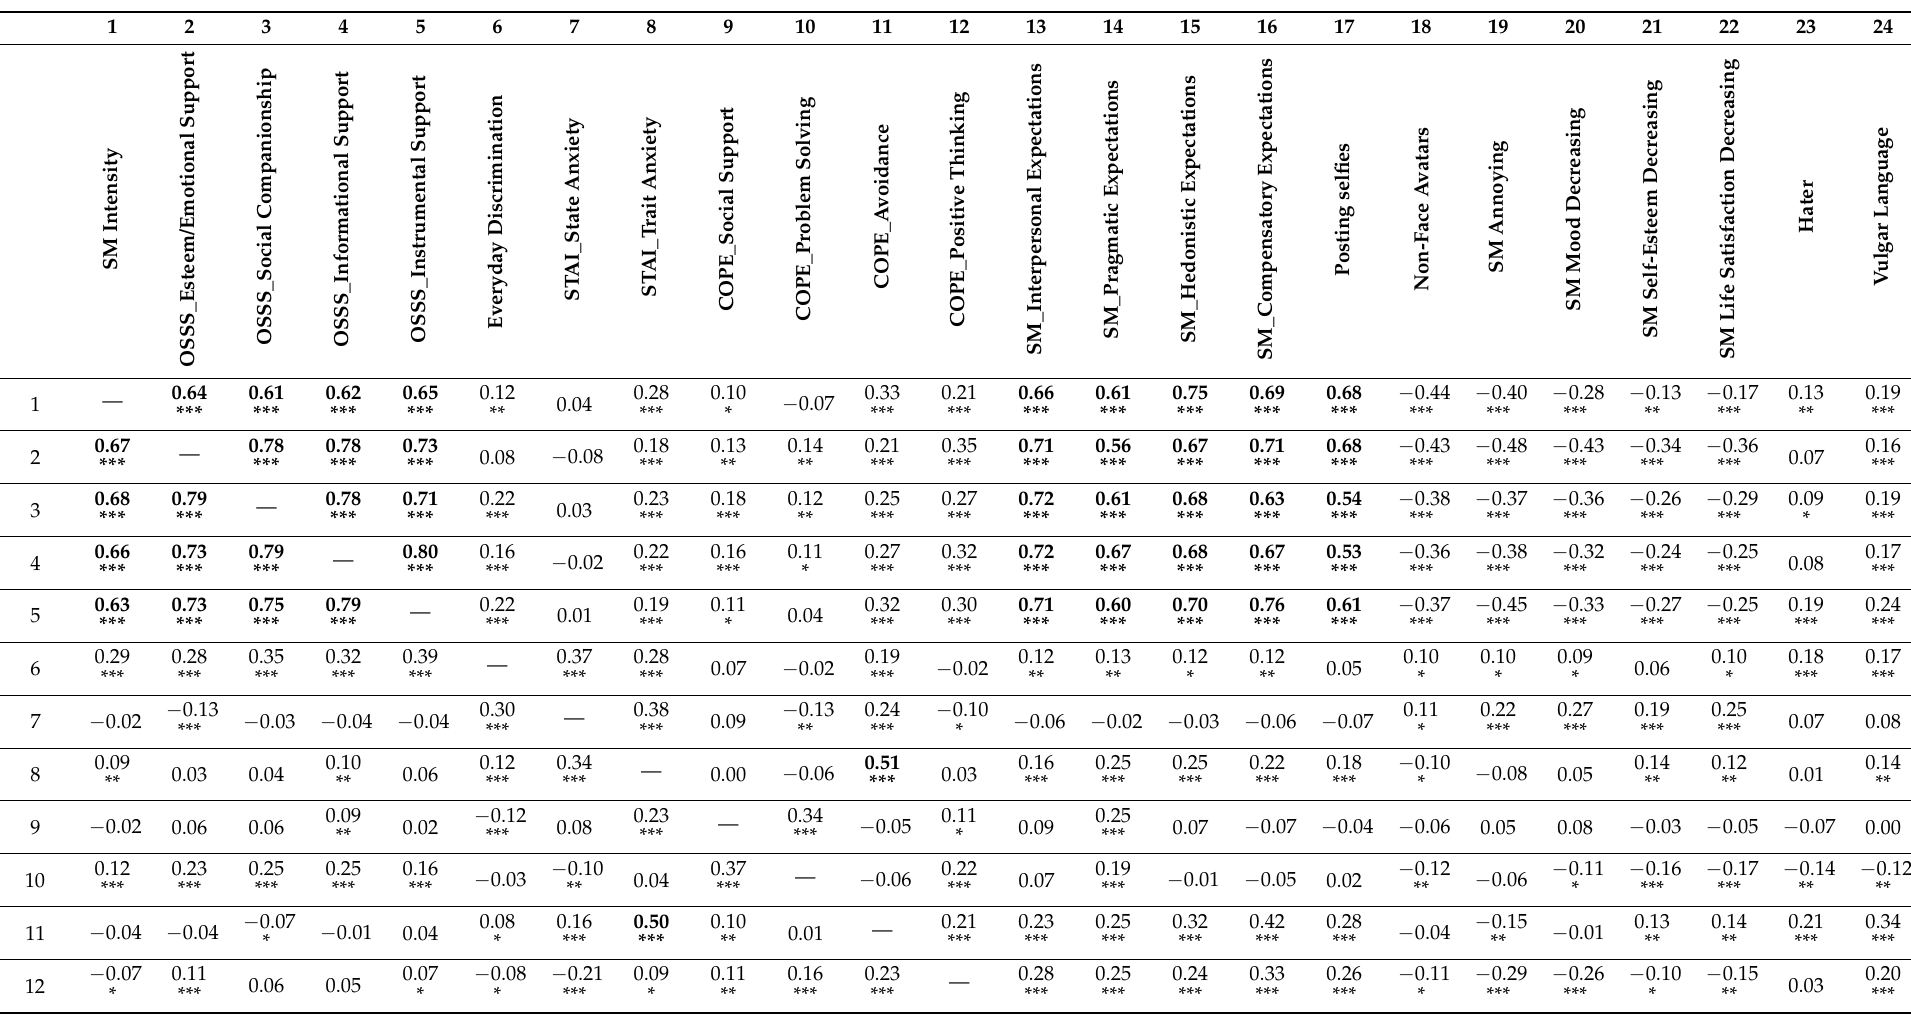
Table 2. Correlation of study variables for the subgroups of theists and